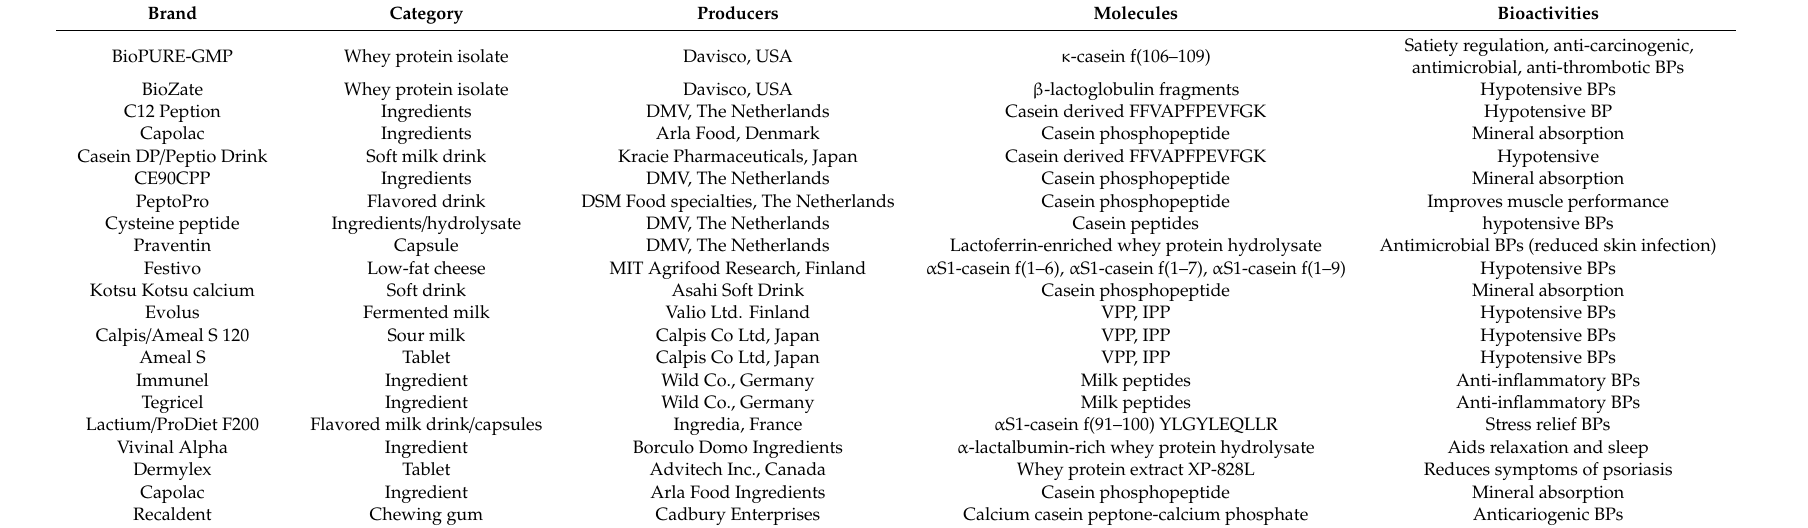
Table 1. Principal milk-derived products containing bioactive peptides (BPs) currently